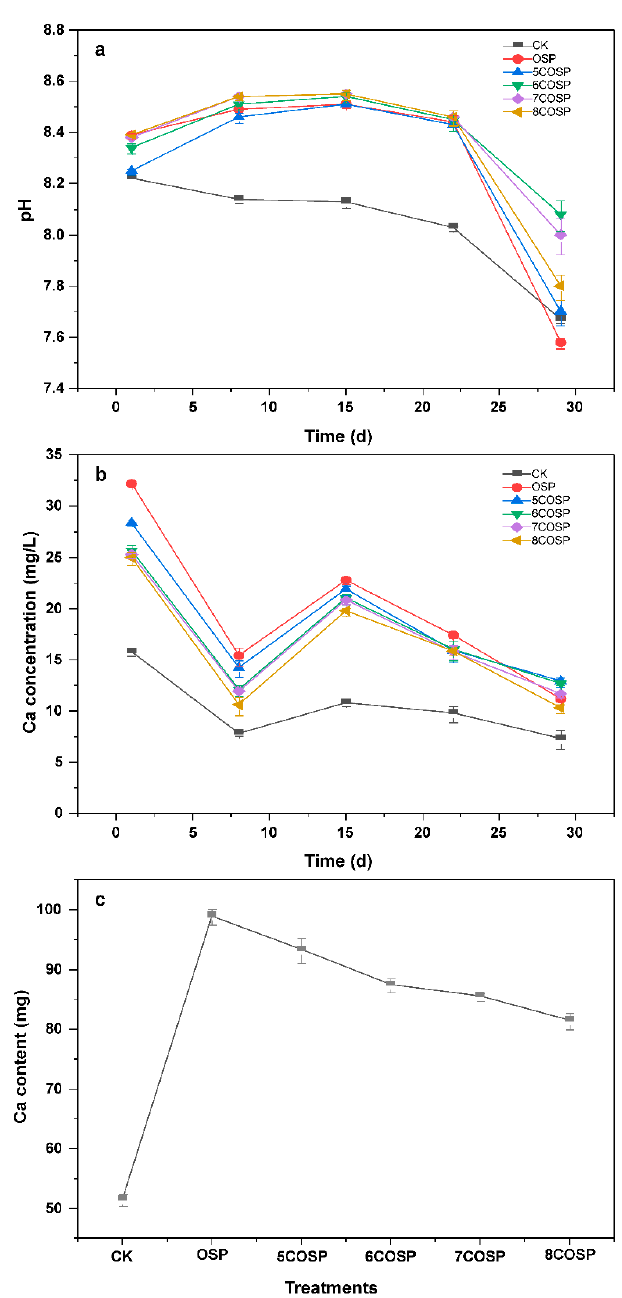
Figure 8. Variations in ( a ) pH and ( b ) Ca concentrations and ( c ) cumulative leaching concentrations under the treatments. CK: Urea treatment with N application level of 200 mg/kg; OSP: 0.2 wt.% OSP; 5–8COSP: 0.2 wt.% OSP calcined at various temperatures; particle size of the OSP and four COSPs = 0.15